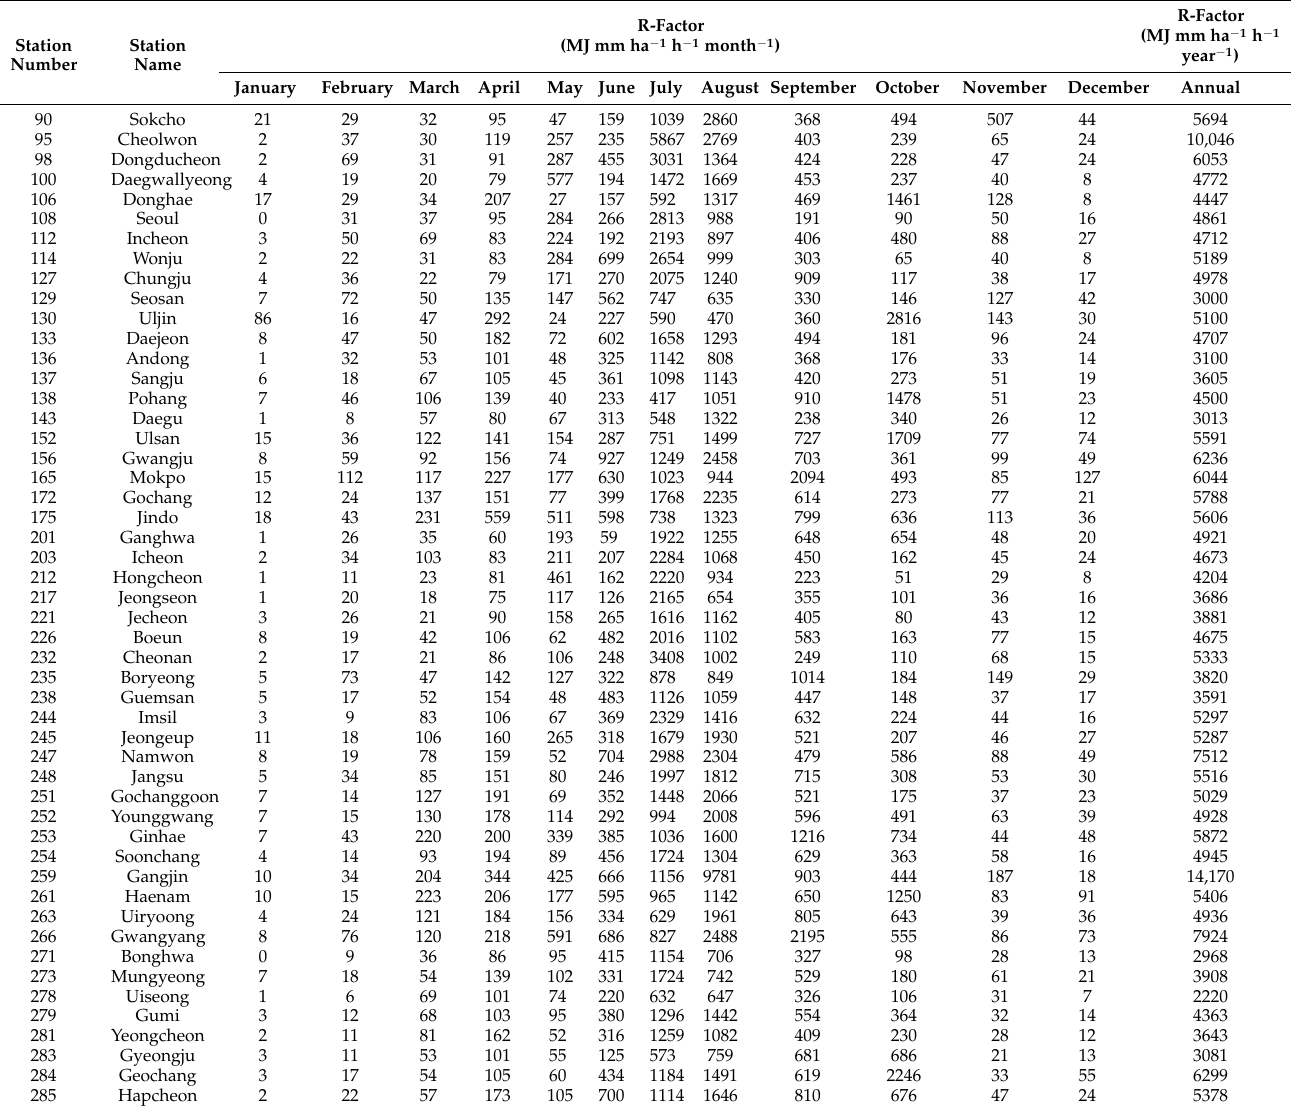
Table 4. Monthly R-factor calculated by the Universal Soil Loss Equation